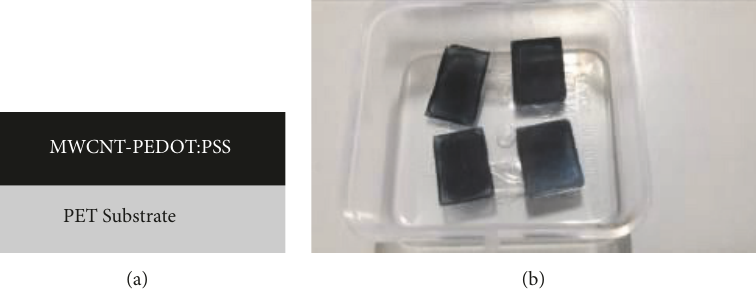
Figure 1: (a) Schematic drawing of the thin film side view. (b) Samples of the prepared MWCNT-PEDOT: PSS thin film.